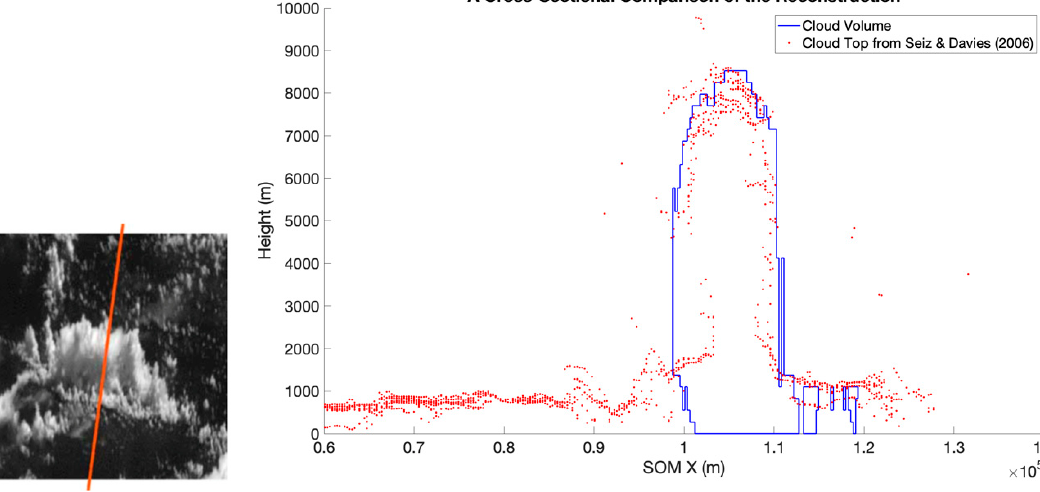
Figure 10. A cross-sectional comparison between the reconstructed volume from the custom cloud mask without the wind correction and the result from Reference [21]. Reference [21]’s result consists of outcomes for eight stereo pairs of different view angles, but here they are all expressed in one color.